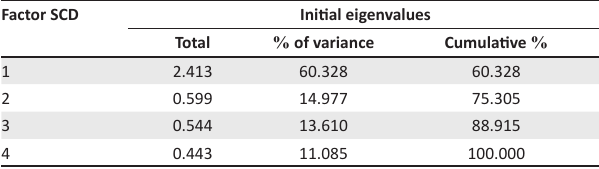
TABLE 3: Initial eigenvalues for structural capital disclosure (second-level factor analysis). Factor SCD